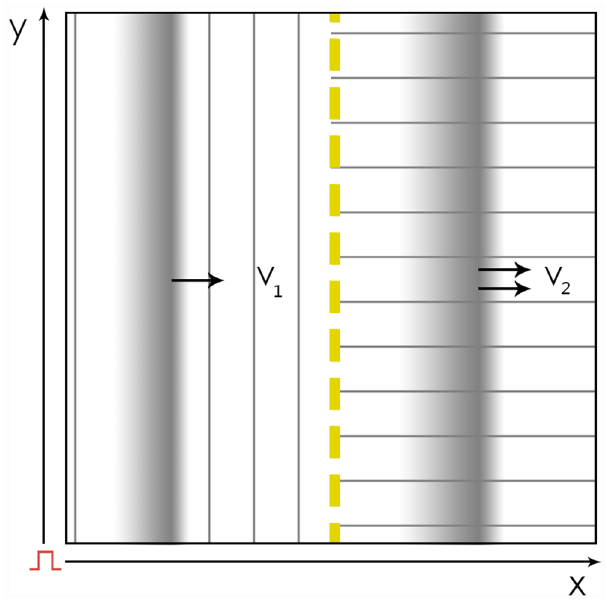
Fig 1. Schematic representation of the computational setup in 2D. The tissue is divided into two parts with an orthogonal fiber orientation. The boundary is shown by the yellow dashed line. In the left part, the fibers (represented by thin lines) are parallel to the boundary, and in the right part, the fibers are orthogonal to the boundary. Two propagating waves are schematically shown as greyscale images. When stimulation was applied to the left border, wave propagation was observed to be translationally symmetric along the y axis and could be studied in 1D